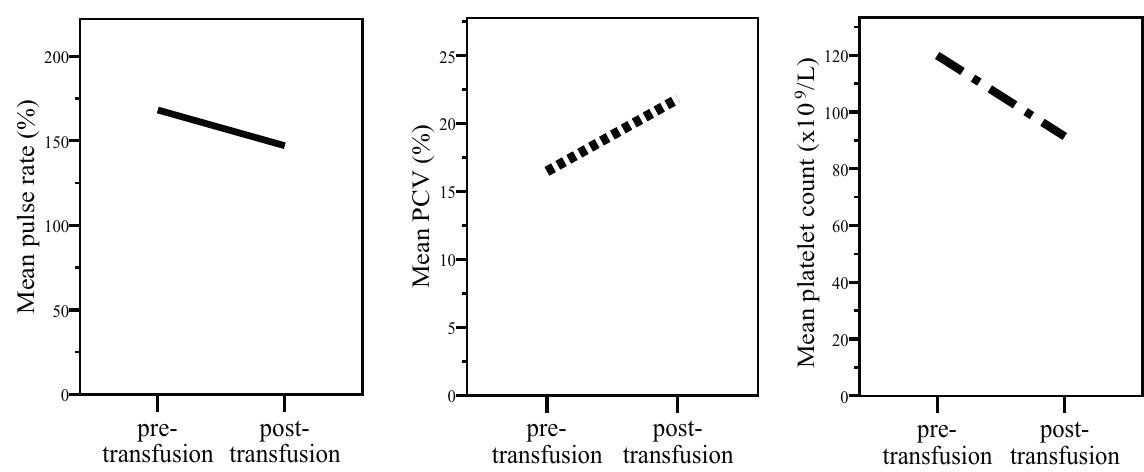
Fig. 3 – Variations of mean pulse rate (A), mean PCV (B) and mean platelet count (C) before and 12h after beginning of transfusion ( n = 19